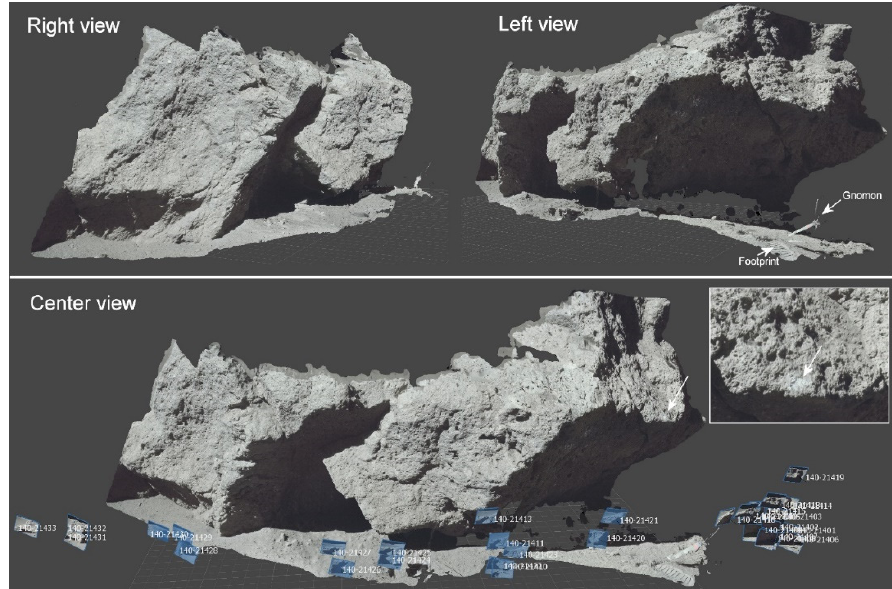
Figure 7. Photogrammetric reconstruction (textured 3-D model) of the fragments 4–5 at Station 6. The position and orientation of the 33 Apollo images labeled AS17-140-21401 to AS17-140-21433 computed by Metashape is indicated by annotated squares on the bottom perspective view. The gnomon is fully reproduced in 3-D, as is a footprint, allowing for a precise scaling of the model. The inset shows the markings (white arrow) left by astronauts when hammering the boulder for sampling.